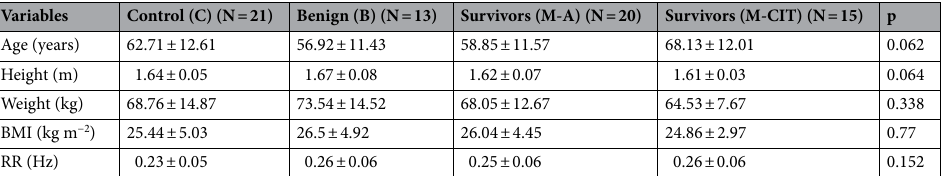
Table 1. Proband’s characteristics (mean ± SD). M-A survivors with active cancer, M-CIT survivors after completed initial treatment, BMI body mass index, RR respiration